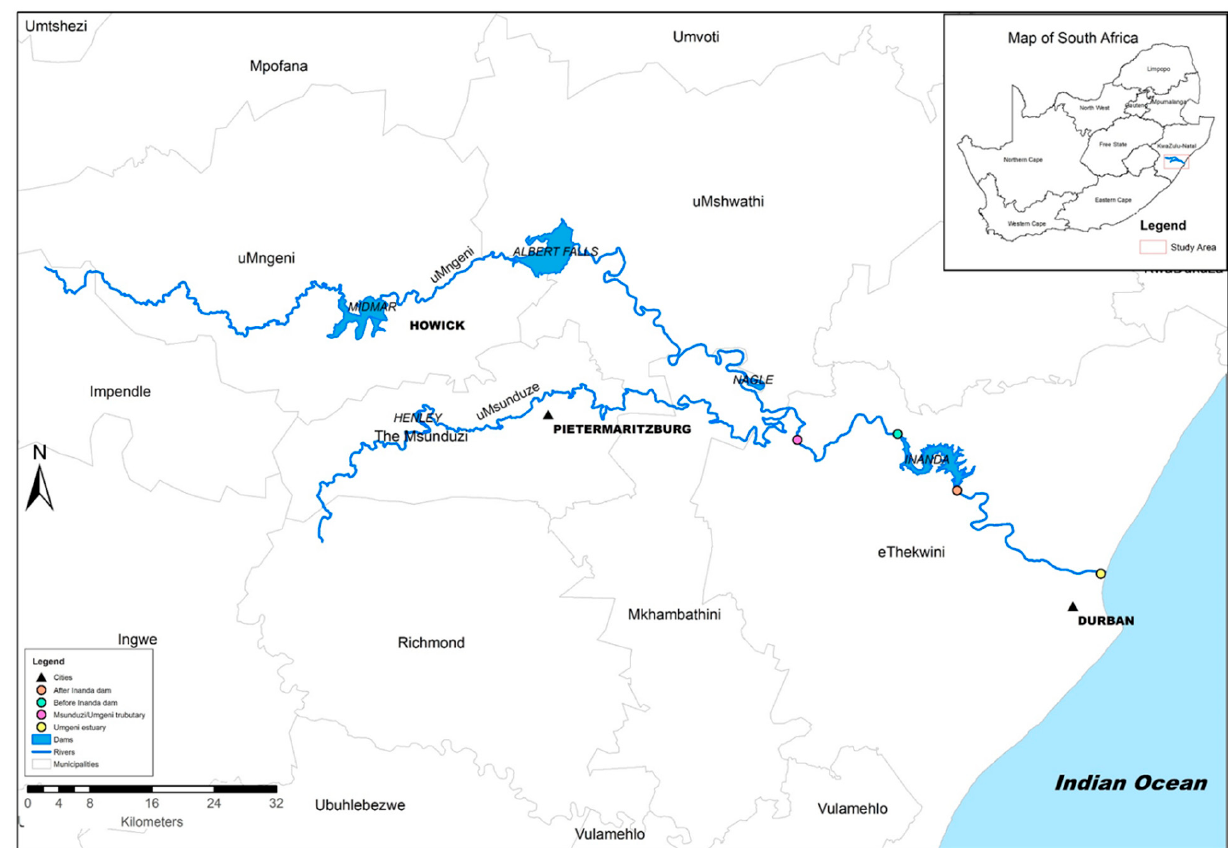
Figure 1. Map for the sediments sampling points.